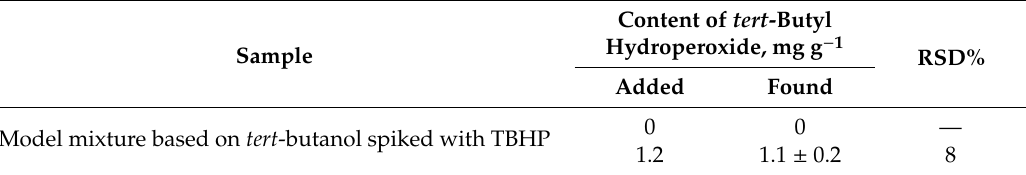
Table 4. Determination of tert -butyl hydroperoxide in a model sample ( n = 3, p = 0.95).